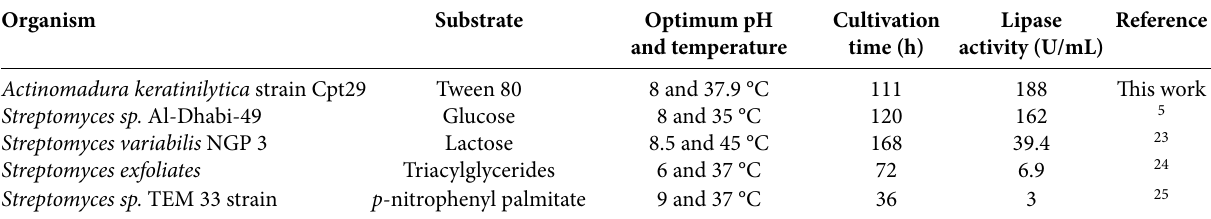
Table 5. Lipase activity recorded in some Actinomycetes.